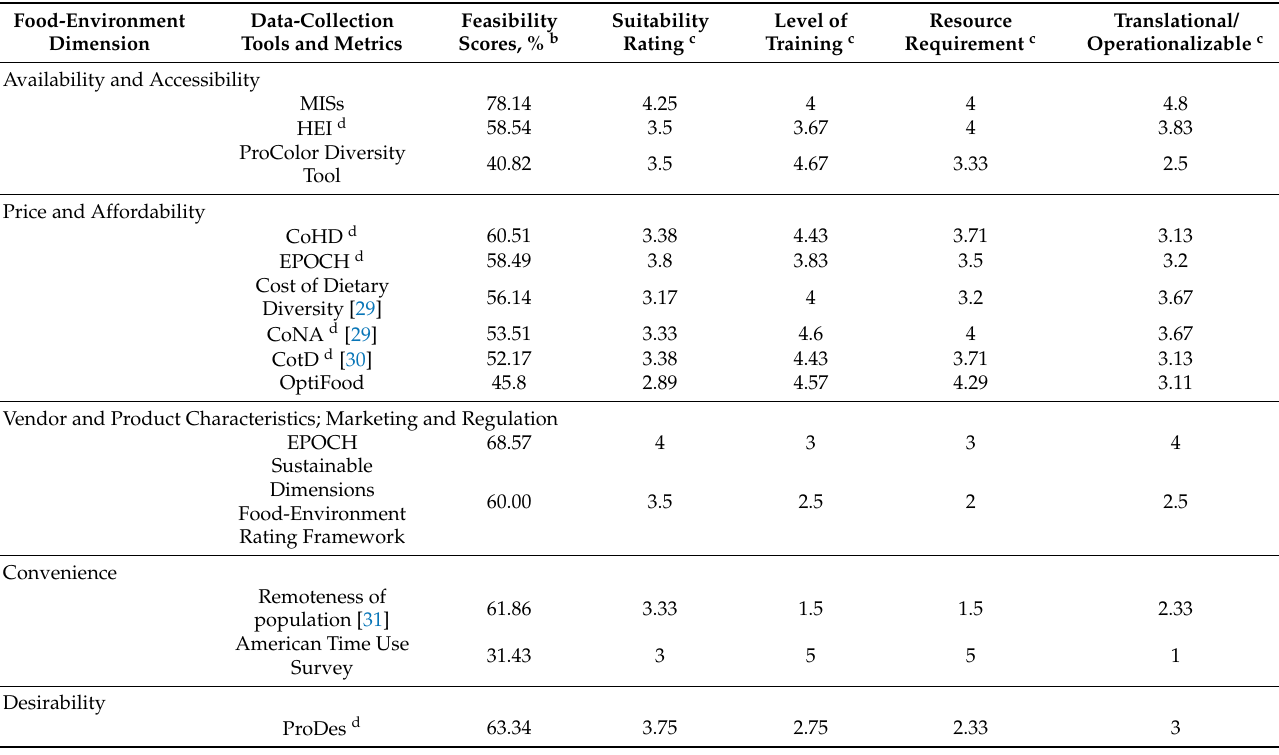
Table 2. Tools and Metrics with Feasibility Scores for Evaluating Informal and Formal Market Food Environments in LMICs a . Food-Environment